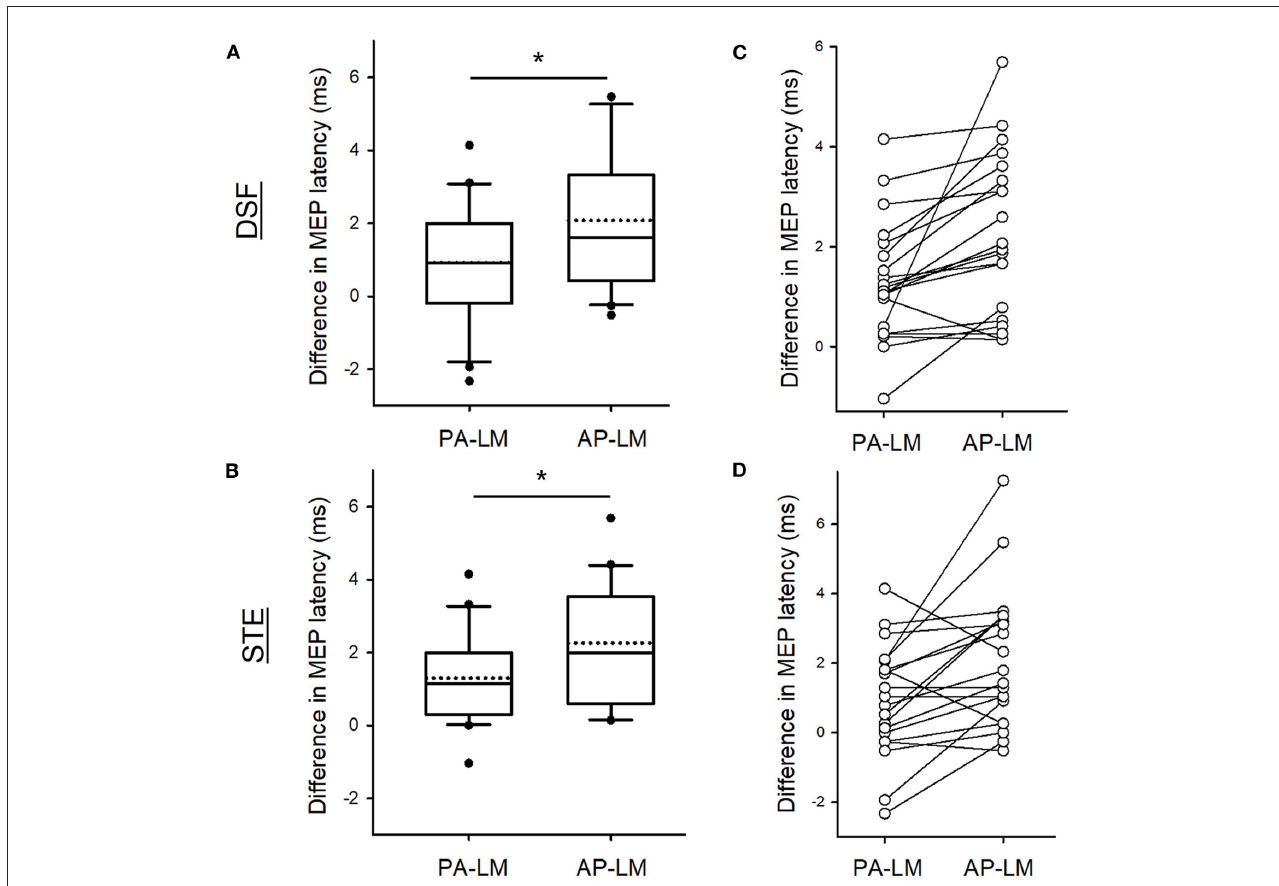
FIGURE3 Differences in MEP latencies between coil orientations. Group data showing the differences in the MEP latencies between the PA and LM and between AP and LM coil orientation during the DSF (A) and during the STE (B) . Individual data demonstrating that the majority of the participants having a longer AP-LM latency compared with PA-LM latency in both tasks (C, D) . Solid lines indicate median values; dotted lines indicate mean values. The box is interquartile range; error bars denote maximum and minimum values. * p < 0.05 between